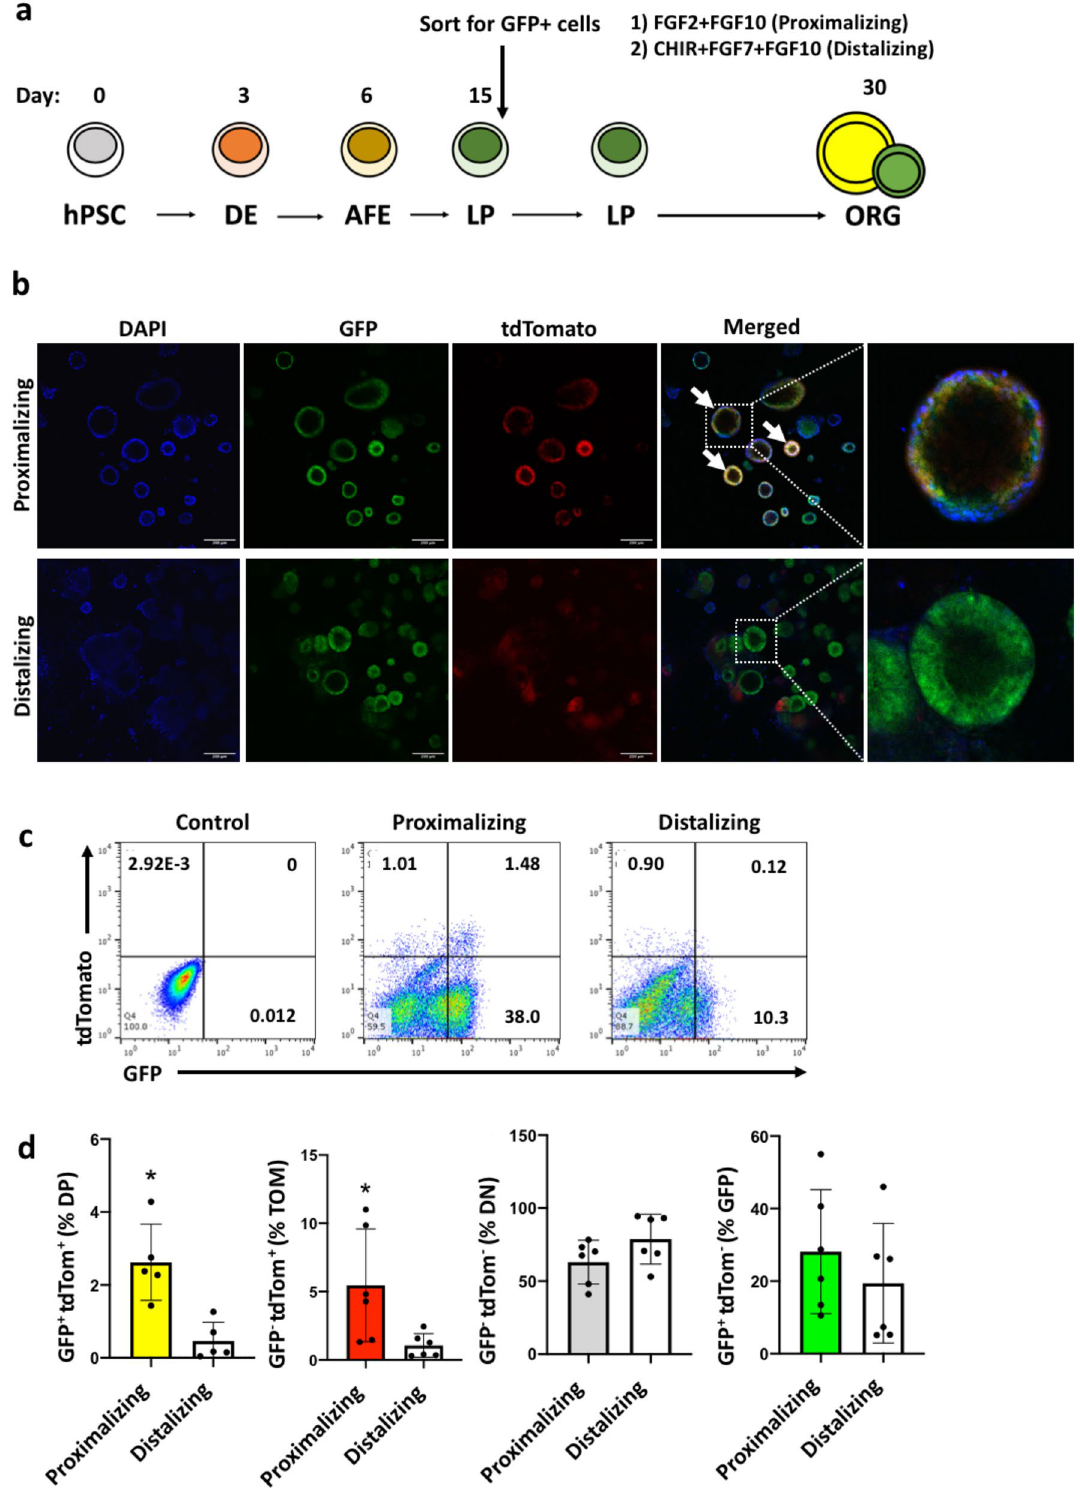
Figure 4. Differentiation of NKX2-1 GFP ;TP63 tdTomato hiPSCs into lung organoids. ( a ) Protocol for differentiating NKX2-1 GFP ;TP63 tdTomato hiPSCs into proximalized and distalized lung organoids based on McCauley et al. 38 and Jacob et al. 39 . hPSC human pluripotent stem cell, DE definitive endoderm, AFE anterior foregut endoderm, LP lung progenitors, ORG lung organoid. ( b ) Representative images of proximalized and distalized lung organoids derived from the NKX2-1 GFP ;TP63 tdTomato hiPSC line. White arrows indicate lung organoids containing double positive cells. ( c ) Flow cytometry analysis of lung organoids cultured in proximalizing and distalizing conditions. Representative dot plots shown. ( d ) Quantification of the 4 populations in the lung organoids grown in the differentiation culture conditions. DN double negative (GFP- tdTOM-), DP double positive (GFP + tdTOM +), tdTomato + tdTomato-positive only (GFP- tdTOM +), GFP GFP-positive only (GFP + tdTomato-). Data are represented as means ± SD, n = 5. *p < 0.05. t test. Graphs were made and statistical analyses were done using GraphPad Prism 8.0 (GraphPad Software Inc., San Diego, CA, USA) (www.graph